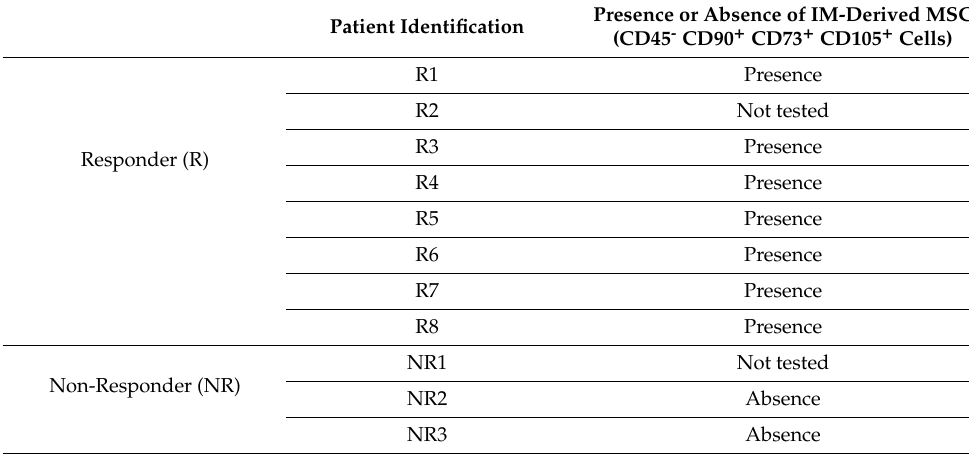
Table 2. Presence or absence of ex-vivo expanded mesenchymal stromal cells in responder (R) and non-responder (NR) patients. IM-derived cells were cultured and characterized as mesenchymal stromal cells (MSC) based on their surface marker expression.